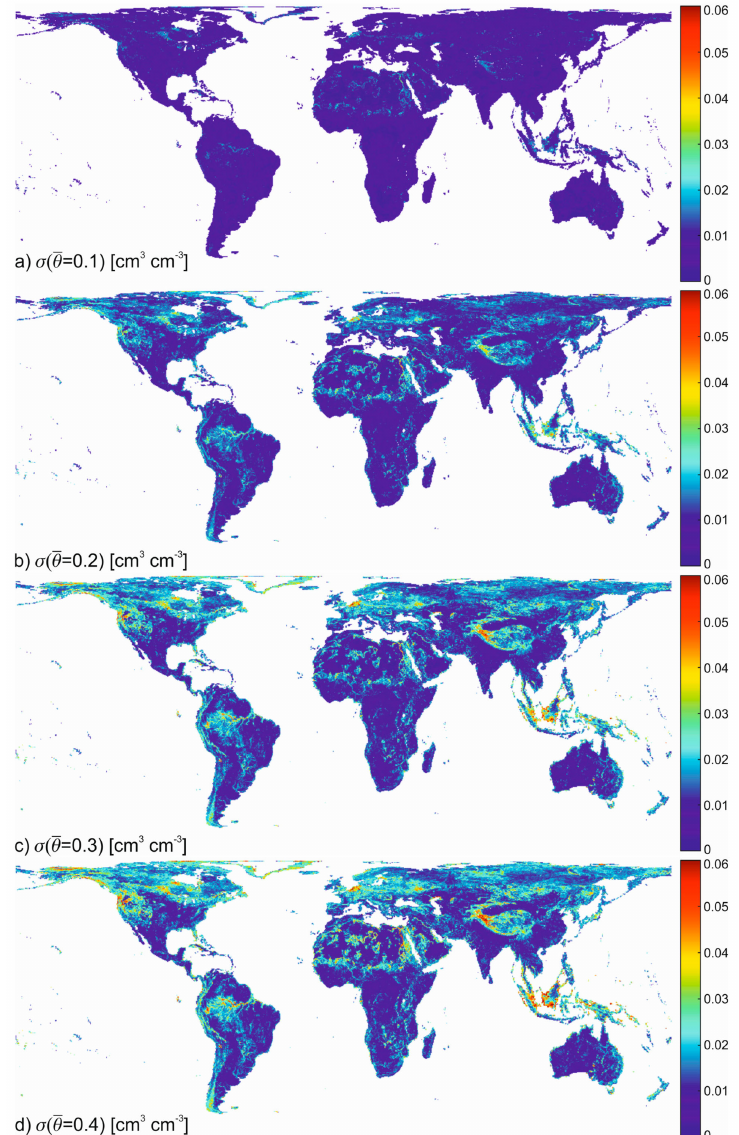
Figure 3. SMAP sub-grid soil moisture standard deviation at specific mean soil moisture values (cid:0) (cid:1) (cid:0) (cid:1) (cid:0) (cid:1) (cid:0) (cid:1) θ = 0.1 θ = 0.2 θ = 0.3 θ = 0.4 ( a ) σ θ ; ( b ) σ θ ; ( c ) σ θ ; ( d ) σ θ